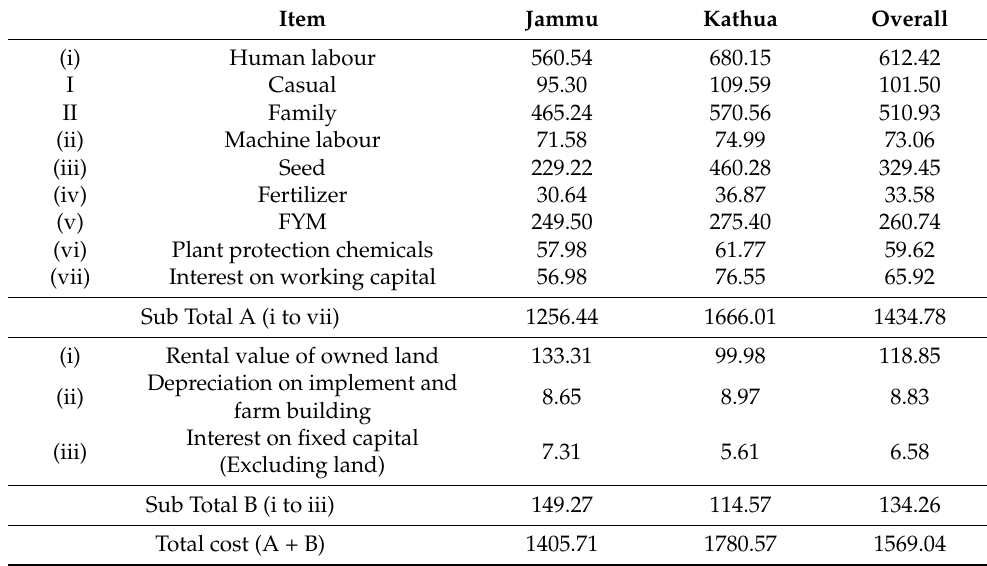
Table 1. Operation-wise cost of cultivation of marigold (USD · ha − 1 ). Item